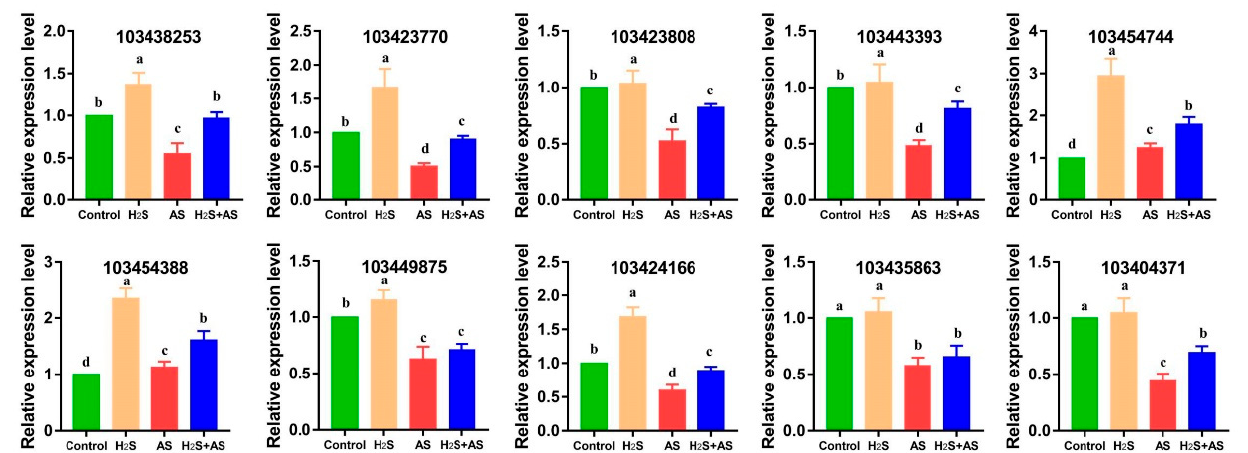
Figure 8. qRT-PCR analysis of DEGs in roots under different treatments. The 18S rRNA was used as a housekeeping gene for normalizing gene expression and to correct for sample-to-sample variation. The expression level of genes in the roots of plants grown under control conditions was assigned to 1. The bar represents standard deviation (SD) of the mean, different letters suggest significant differences among the treatments at p <